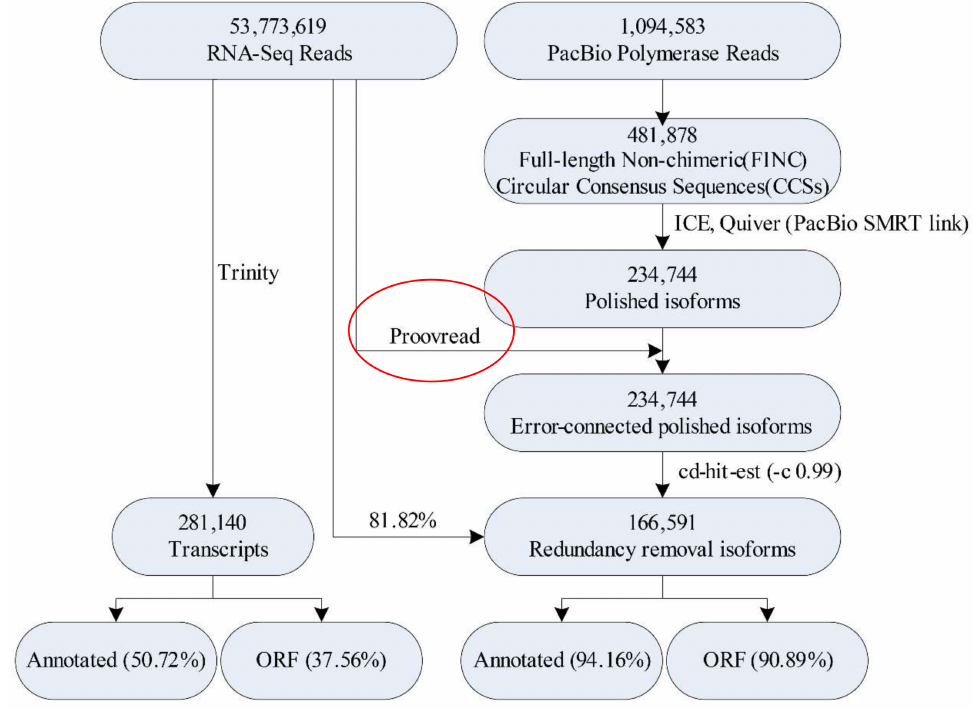
Figure 2. The analysis process of Illumina-seq and SMRT-seq in Camellia oleifera . ORF—open reading